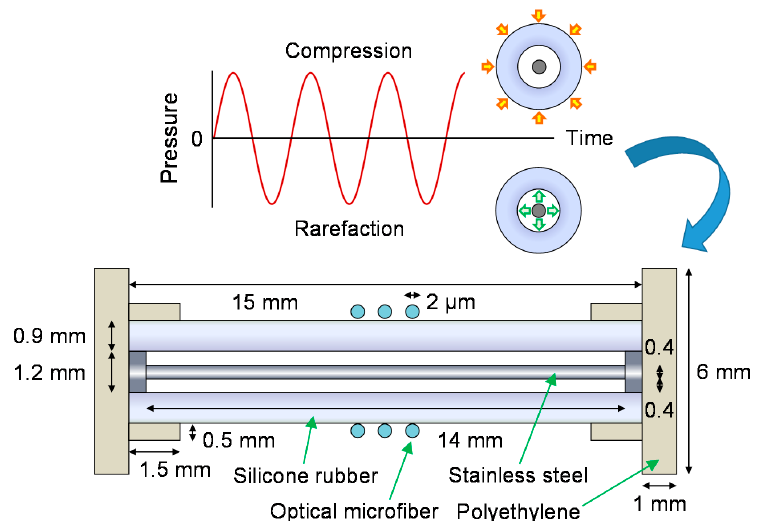
Figure 17. Working principle of the air-backed mandrel bound with a microfiber coil seen from the transverse perspective, and a schematic diagram of the construction seen from the axial perspective. An experimental demonstration was made using an MC of 2 µm core diameter and 35 mm uncoiled length, with a mandrel of 3 mm diameter and 15 mm height. The MC was embedded in the outer layer of the air-backed mandrel via UV-curable polymer. The sensitivity is 4.9 ± 0.5 mrad/Pa for an acoustic signal of 70 Hz. Its frequency response is shown in Figure 18 with average values of − 165.9 dB re. rad/µPa (i.e., − 136.7 dB re. rad/(µPa·m)) and –171.2 dB re. rad/µPa (i.e., − 142.1 dB re. rad/(µPa·m)) from 40 Hz to 500 Hz and 1.5 kHz to 4 kHz respectively. The detection limits are also plotted as a function of frequency, with average values of 31.7 dB SPL and 37.0 dB SPL from 40 Hz to 500 Hz and 1.5 kHz to 4 kHz, respectively.